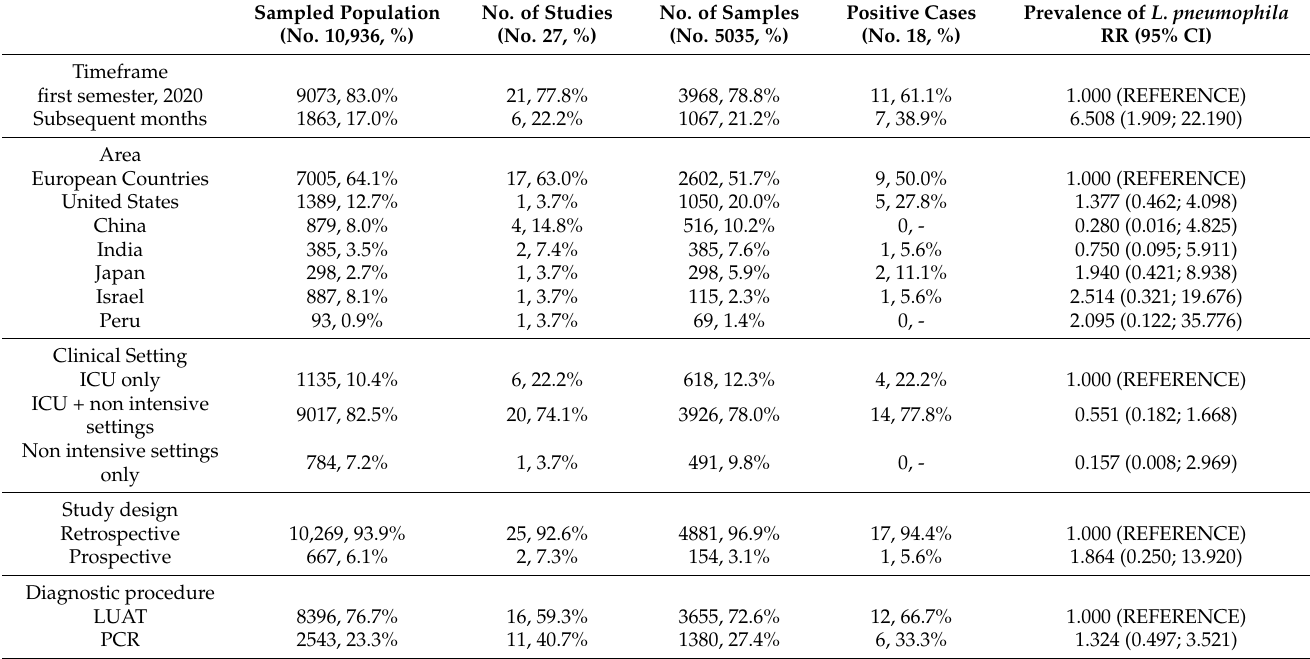
Table 2. Comparison of the prevalence rate for the carriage of Legionella pneumophila between the settings and design of the study. Notes: RR = Rate Ratio; 95% CI = 95% Confidence Intervals; ICU = intensive care unit; LUAT = Legionella urinary antigen test; PCR = polymerase chain reaction. Sampled Population No. of Studies No. of Samples Positive Cases Prevalence of L. pneumophila (No. 10,936, %) (No. 27, %) (No. 5035, %) (No. 18, %) RR (95%